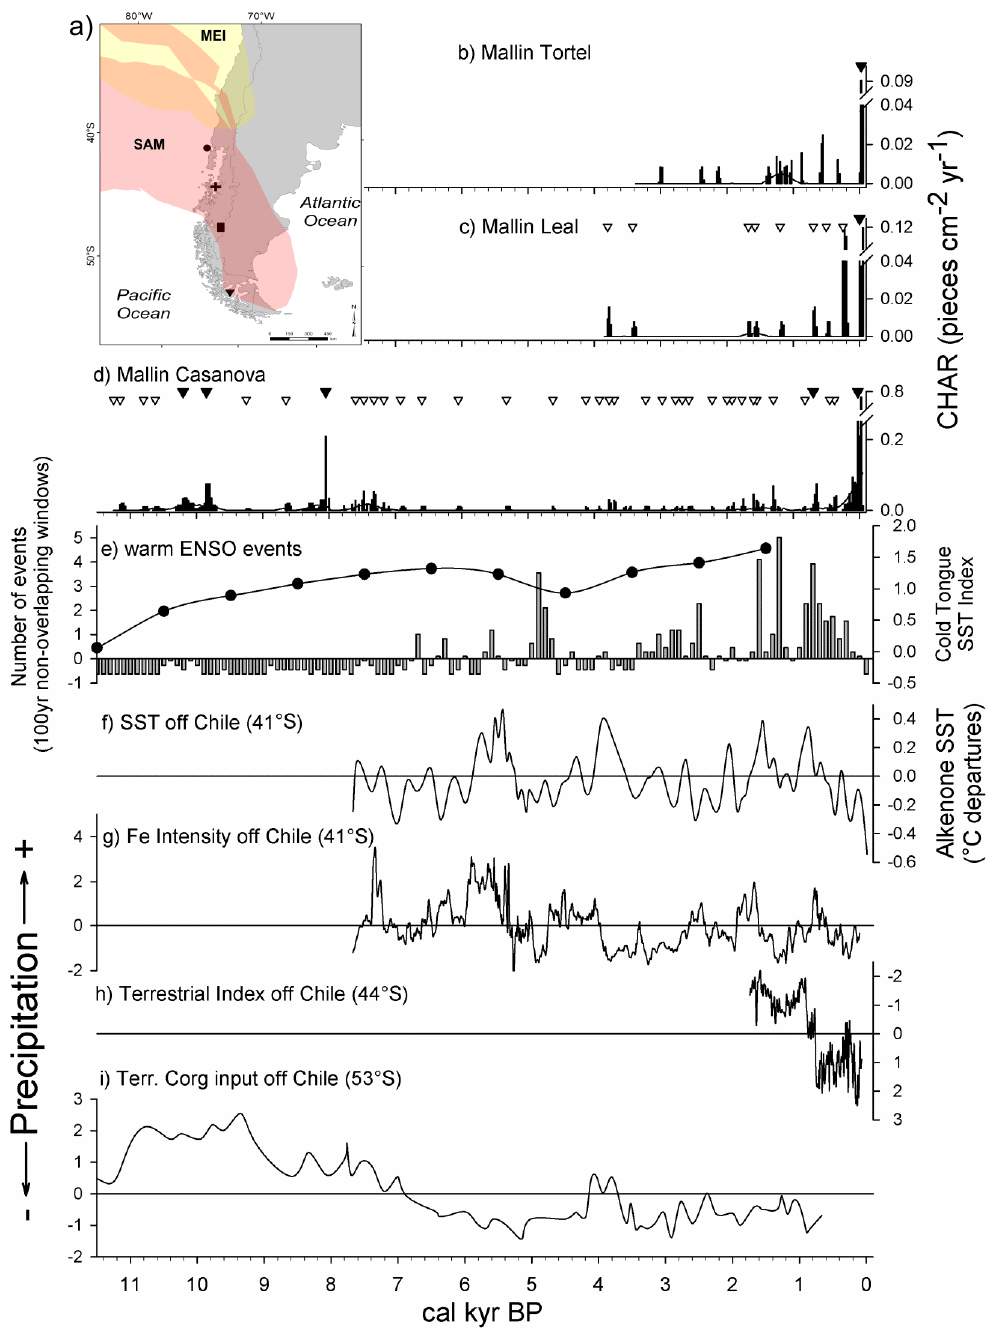
Fig. 7. (a) Regional-scale teleconnection between the Southern Annular Mode (SAM) and the Multiproxy ENSO Index (MEI) and precipi- tation in SSA for the 1957–2007 period (modified from the National Centers for Environmental Prediction-National Center for Atmospheric Research [NCEP-NCAR] Reanalysis; 2.5 × 2.5 ◦ grids; Kistler et al., 2001). CHAR peaks (b – d) and climate proxy. CHAR peaks as in Fig. 3, and climate reconstructions are for: (e) ENSO (bars; Moy et al., 2002) and Cold Tongue SST Index (Koutavas and Sachs, 2008), (f) Alkenone (SST at 41 ◦ S; Lamy et al., 2007), (g) Fe intensity (precipitation and linked position of the southern westerly winds, SWW; based on the GeoB3313-1 iron record at 41 ◦ S; Lamy et al., 2001), (h) Terrestrial Index (PC1 for the C/N ratio, δ 13 C, and δ 15 N at 44 ◦ S; Sep´ulveda et al., 2009), and (i) terrestrial organic carbon accumulation (precipitation and linked position of the southern westerly winds, SWW; based on core TML1 at 53 ◦ S; Lamy et al., 2010). Antiphase trends between (g) the Cold Tongue SST Index and (i) the terrestrial organic carbon represents strength of SSW in SSA (Lamy et al.,